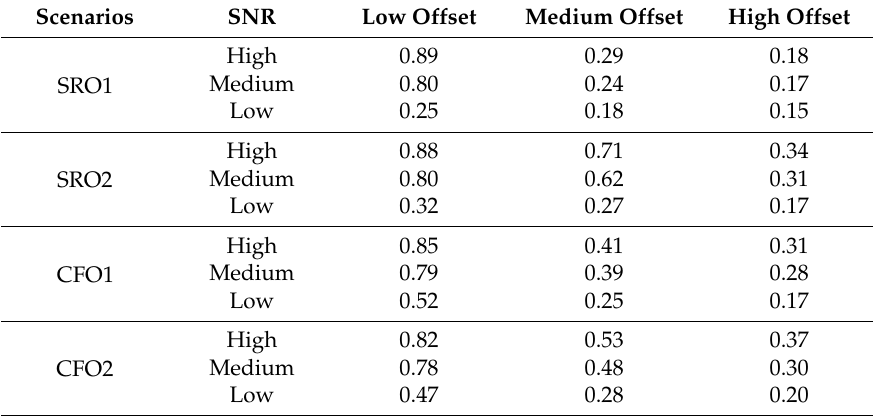
Figure 6. Overall classification accuracy for various offsets in Ideal, SRO1, SRO2, CFO1, CFO2, with SNR fixed at 20 dB ( a ) frequency offsets in Ideal, CFO1, CFO2; ( b ) sample rate offsets in Ideal, SRO1, SRO2. Table 4. Performance comparison for different training scenarios in typical SNR.